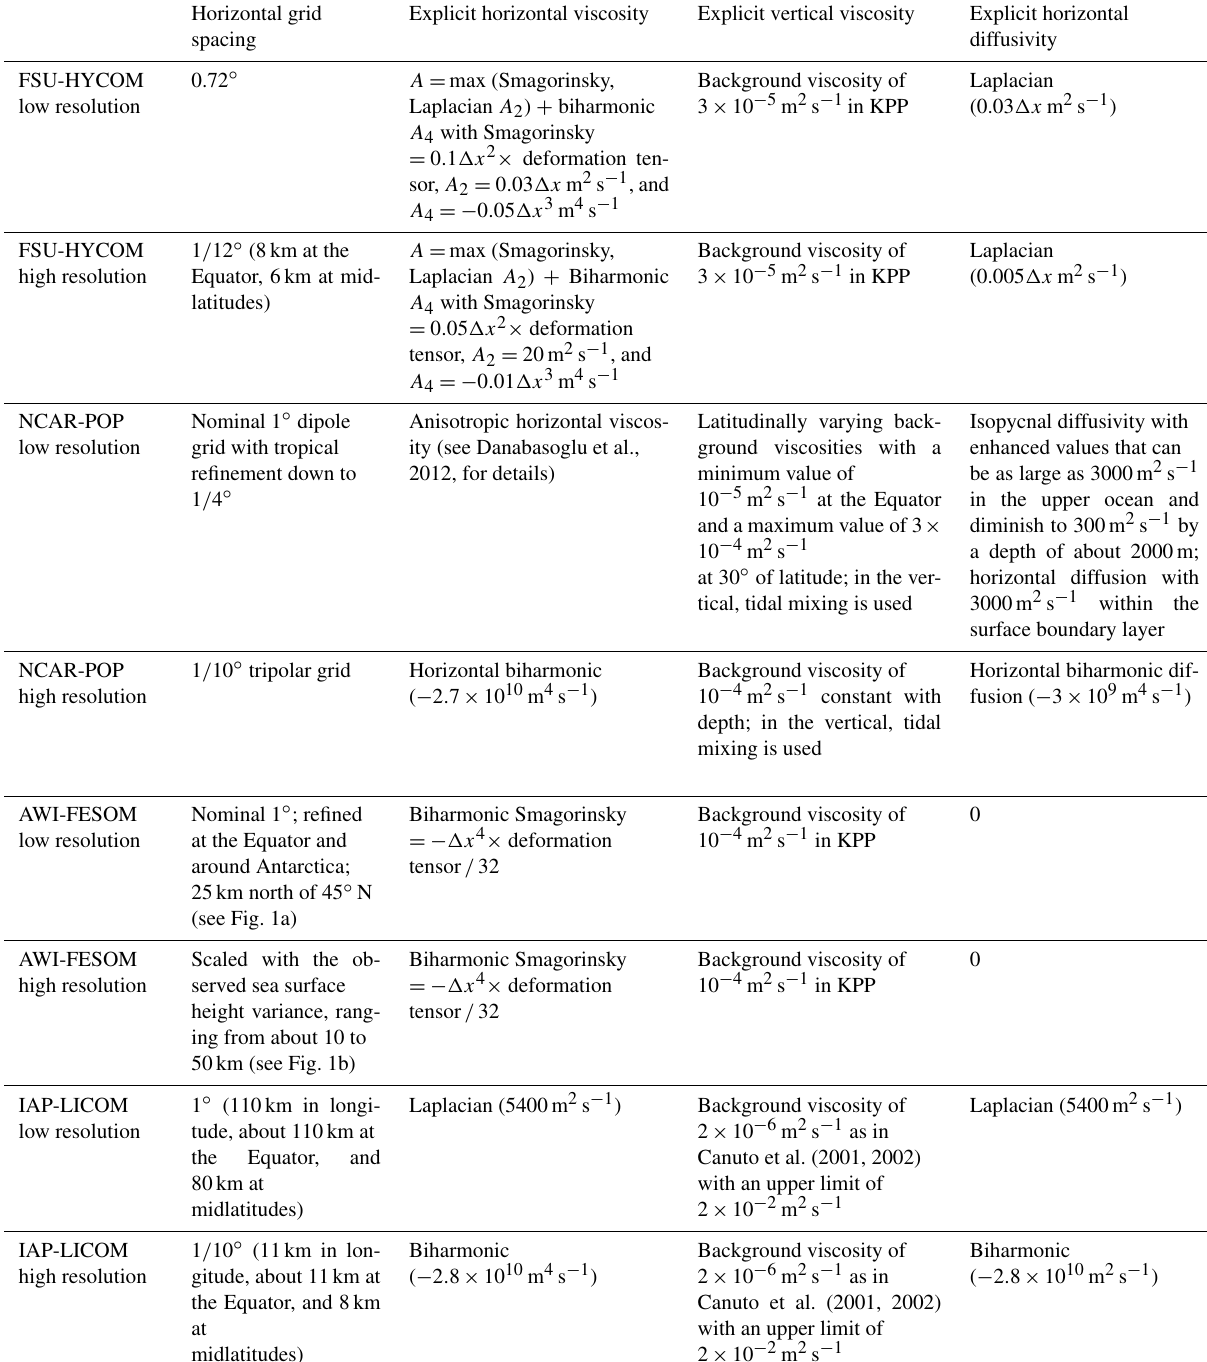
Table 1. Model parameters for the low- and high-resolution configurations. Horizontal